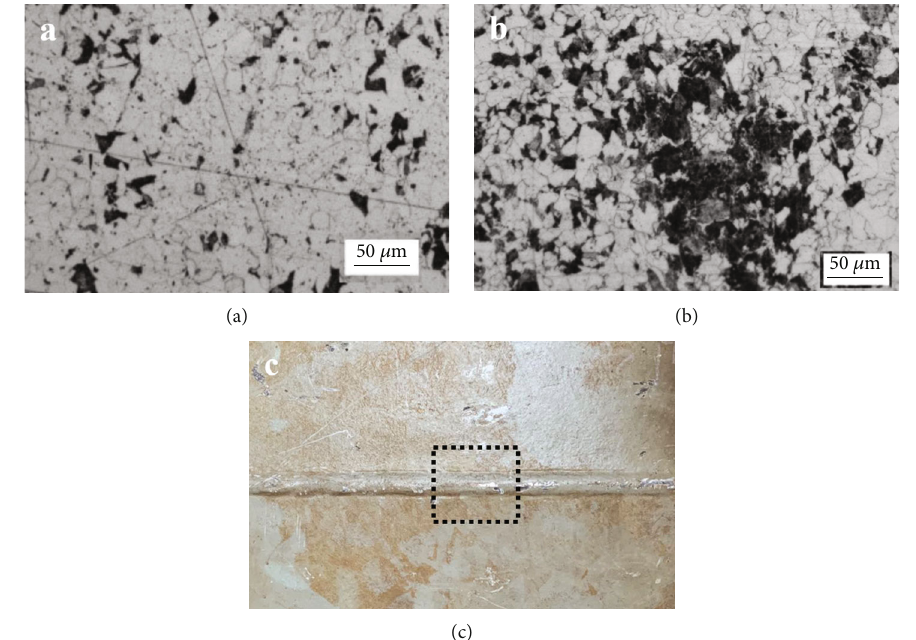
Figure 3: (a) Metallograph picture of the WZ; (b) metallograph picture of the HAZ; (c) sampling location of the welding area.